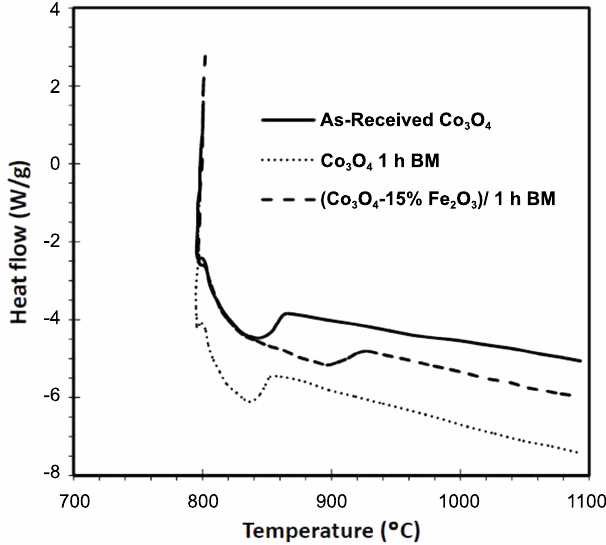
Fig. 7. DSC curves of as-received Co 3 O 4 , 1 h ball milled Co 3 O 4 , and Co 3 O 4 -15 wt% Fe 2 O 3 /1 h BM.